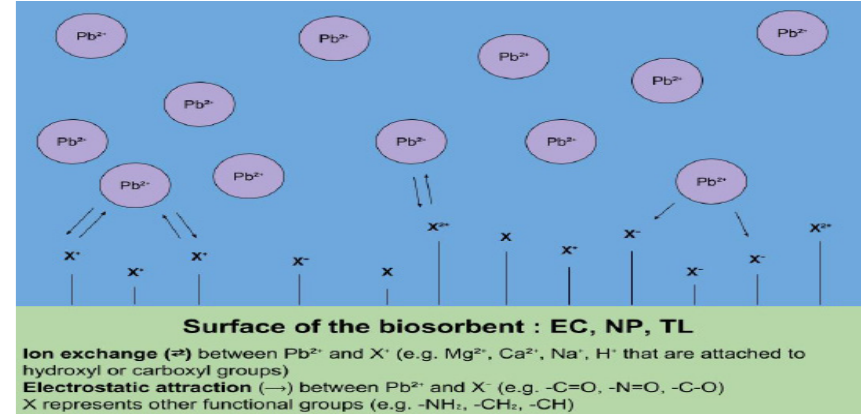
Fig. 8. Schematic illustration of possible interactions involved in the Pb 2+ /biosorbent sorption process